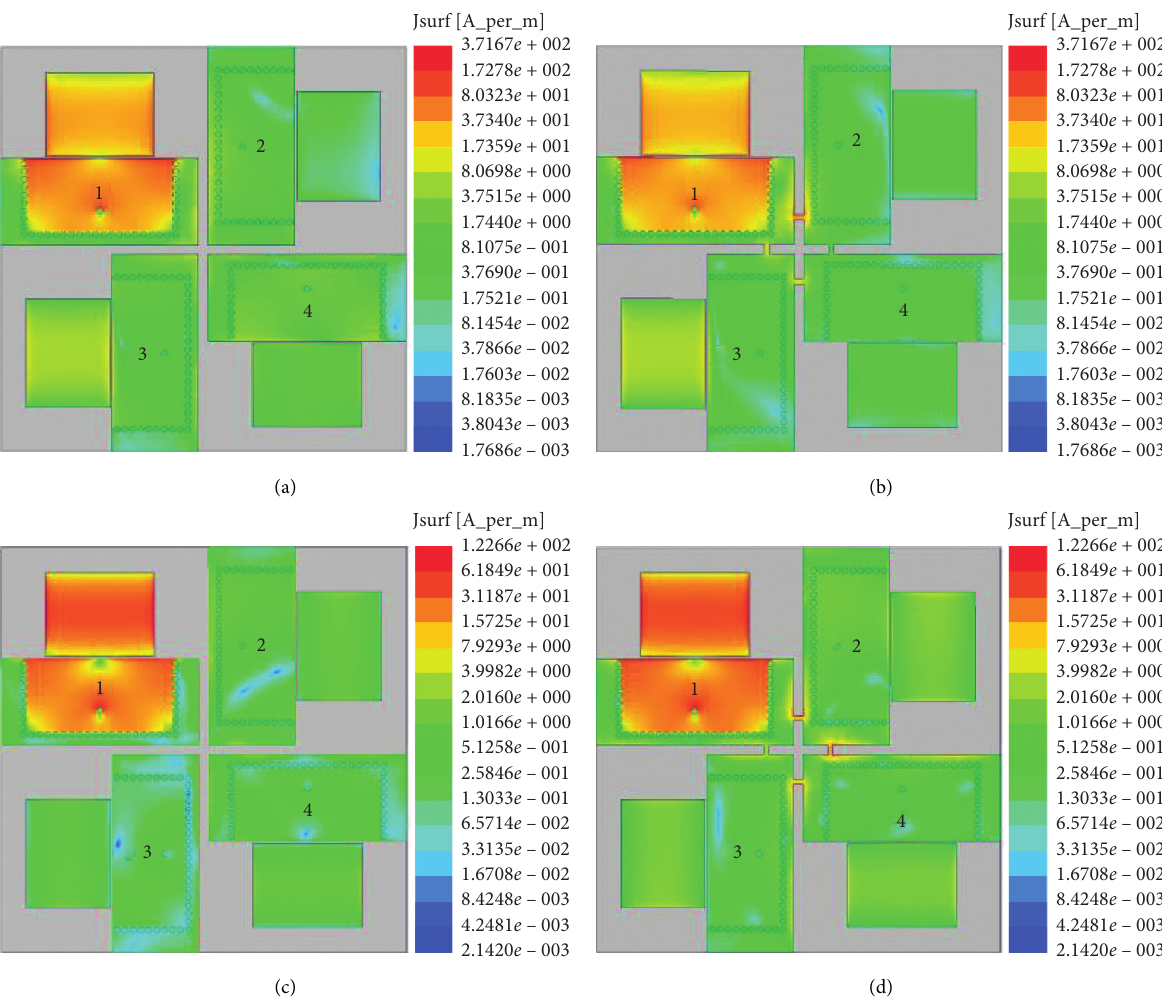
Figure 9: Current distribution when element 1 is excited and other elements are terminated to match loads. (a) 4.46GHz, without SNLs. (b) 4.46GHz, with SNLs. (c) 5.38GHz, without SNLs. (d) 5.38GHz, with